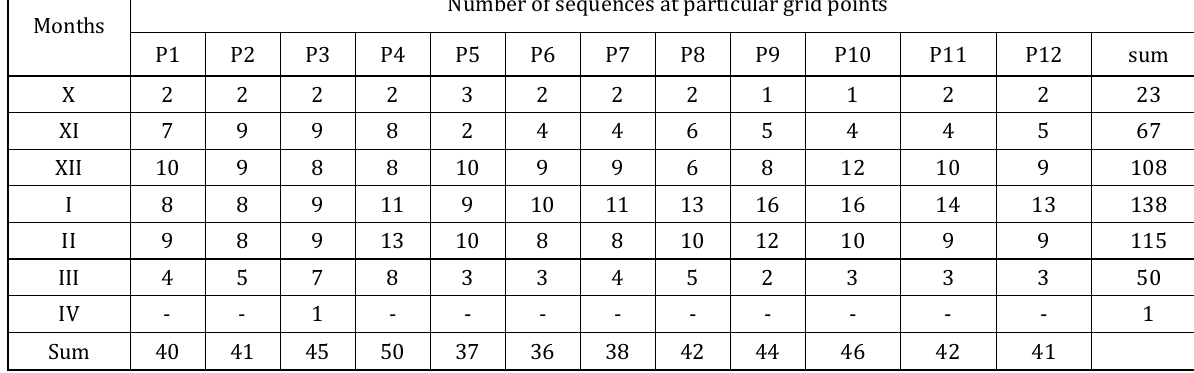
Table 8. Sequences of days with SHP lasting 6 or more days at particular grid points in the period 1951-2015 – from October to